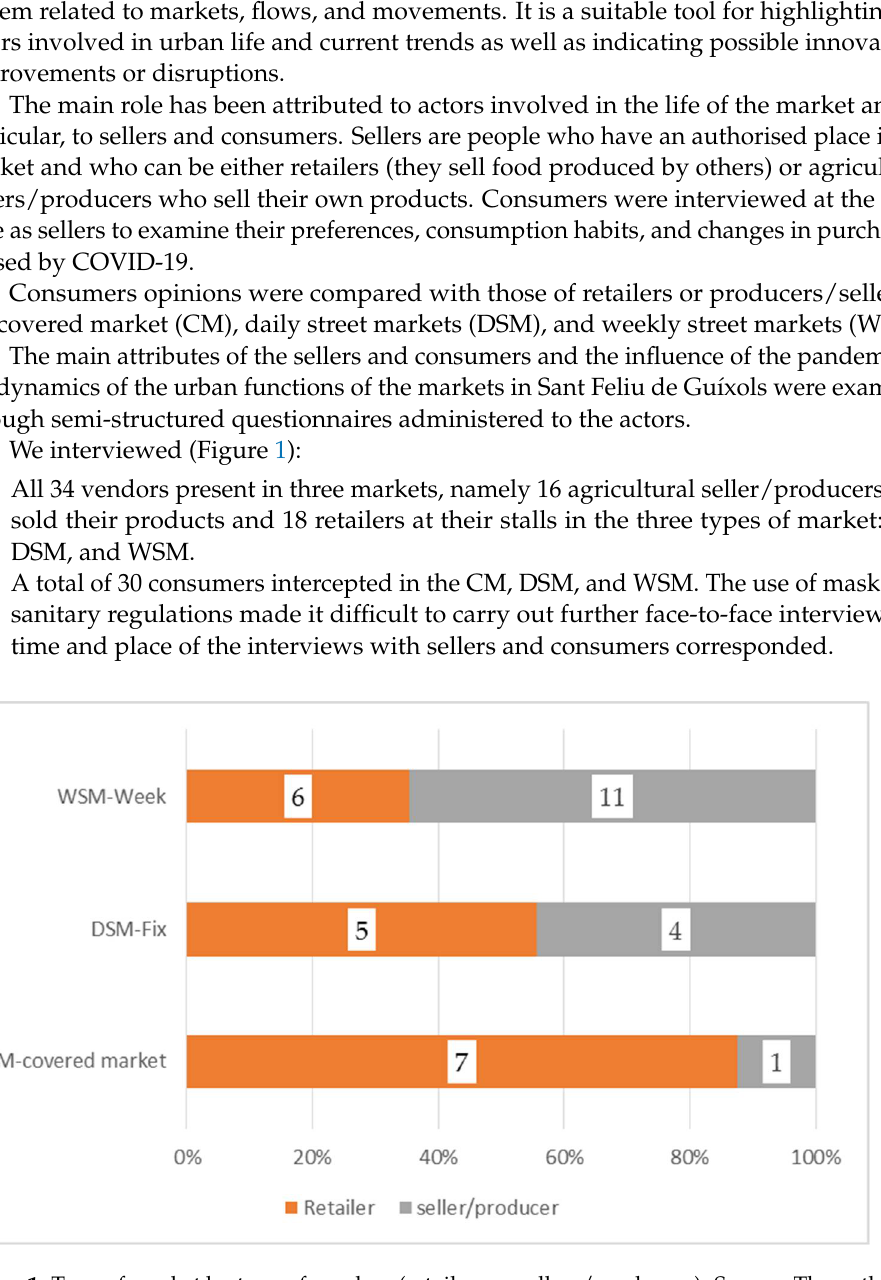
Figure 1. Type of market by type of vendors (retailers or sellers/producers). Source: The authors. Ten-minute personal interviews with sellers and consumers were conducted anony- mously based on two semi-structured questionnaires. The questionnaires were used